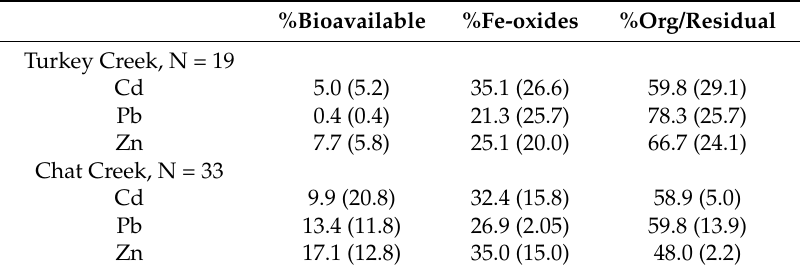
Table 2. Average of percent metal in fractionation in sediment samples from Turkey Creek. Metal fractionation of Chat Creek is shown for comparison purposes. Standard deviation is in